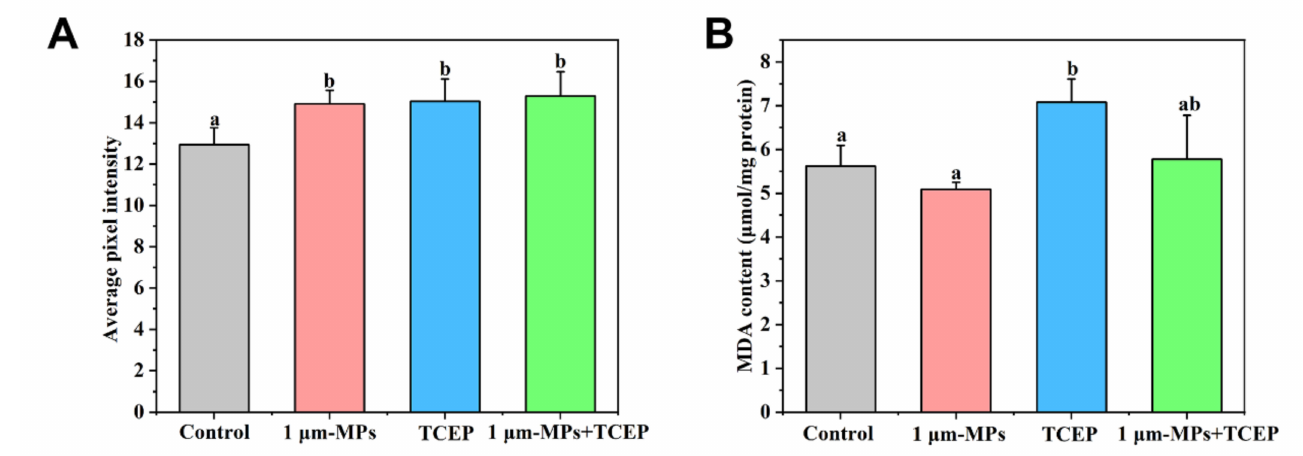
Figure 5. Effect of 1 µ m MPs + TCEP at high concentration (MPs, 2000 µ g/L; TCEP, 65 mg/L) on oxidative status of B. plicatilis (n = 30,000): ( A ) ROS level; ( B ) MDA content. Data are expressed as the mean ± SD of three parallel experiments. Different lowercase letters represent significant differences between experimental groups ( p <